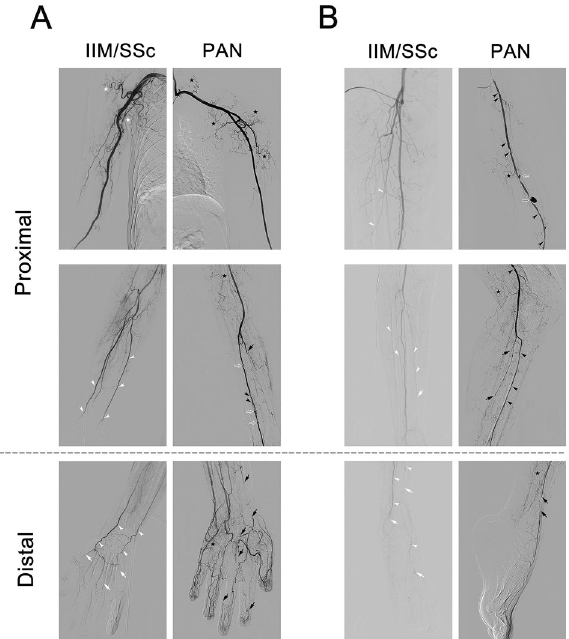
Figure 1. Angiographic features of IIM/SSc-vasculopathy and PAN. Arteries in the ( A ) upper extremities and ( B ) lower extremities of patients with IIM/SSc-vasculopathy and PAN. Diffuse narrowing is indicated by white arrowheads; tapered occlusion by white arrows; multifocal stenosis by black arrowheads; abrupt occlusion by black arrows; aneurysmal changes by empty arrows; grade 2 tortuosity by white stars; and grade 3 tortuosity by black stars. IIM idiopathic inflammatory myopathies, PAN polyarteritis nodosa, SSc systemic